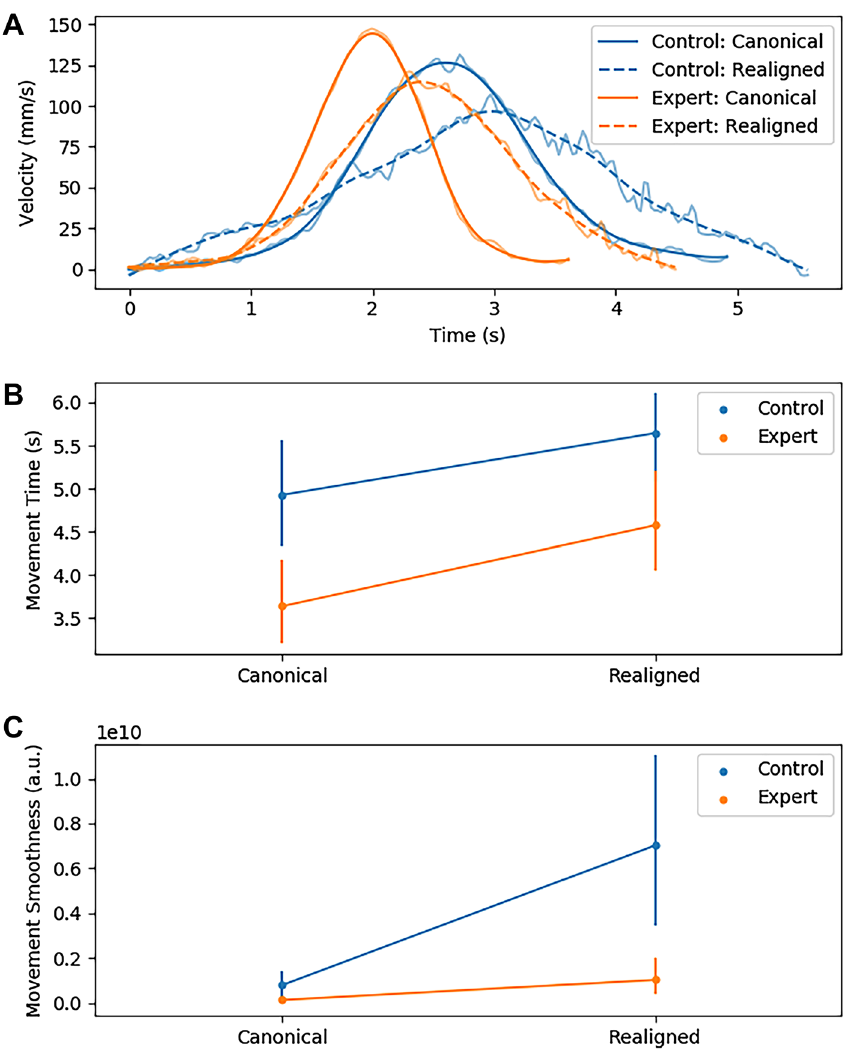
Figure 2. ( A ) Mean movement speed profiles for each group and condition. Semi-transparent lines are the raw signal and opaque lines are a smoothed version using a second order lowpass Butterworth filter with critical frequency 0.05. ( B ) Mean movement time for each group in each condition averaged across all ports. Error bars indicate 95% confidence intervals. ( C ) Mean movement smoothness (tsj) for each group in each condition averaged across all ports. Lower tsj indicates smoother movements. Error bars indicate 95% confidence intervals. The range of the y-axis is from 0 to 1 e 10